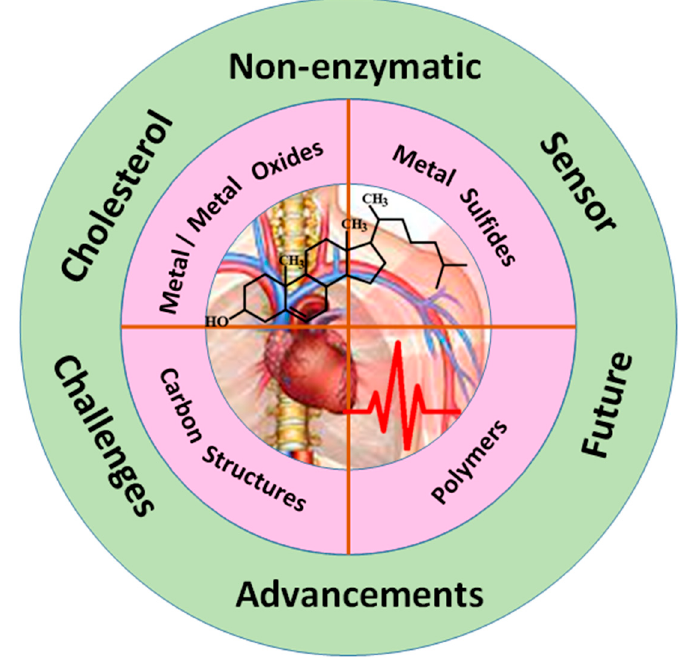
Figure 1. Schematic illustration of nanomaterials-based non-enzymatic cholesterol biosensor.